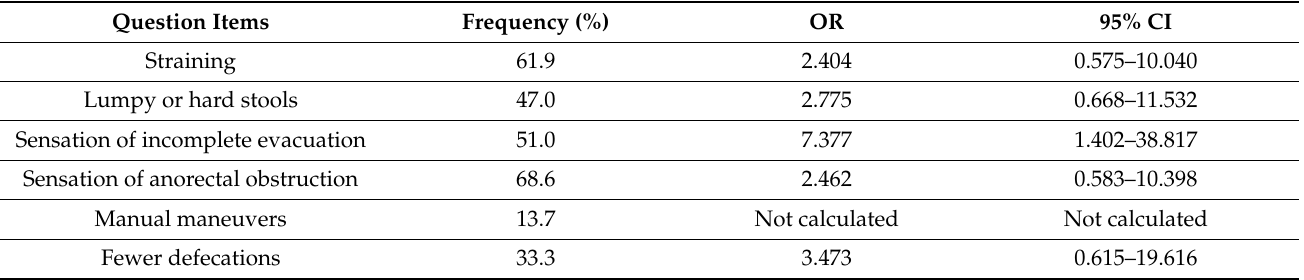
Table 2. Frequencies of constipation symptoms based on Rome III diagnostic questionnaire and their association with patient’s awareness of constipation in multiple system atrophy cohort.